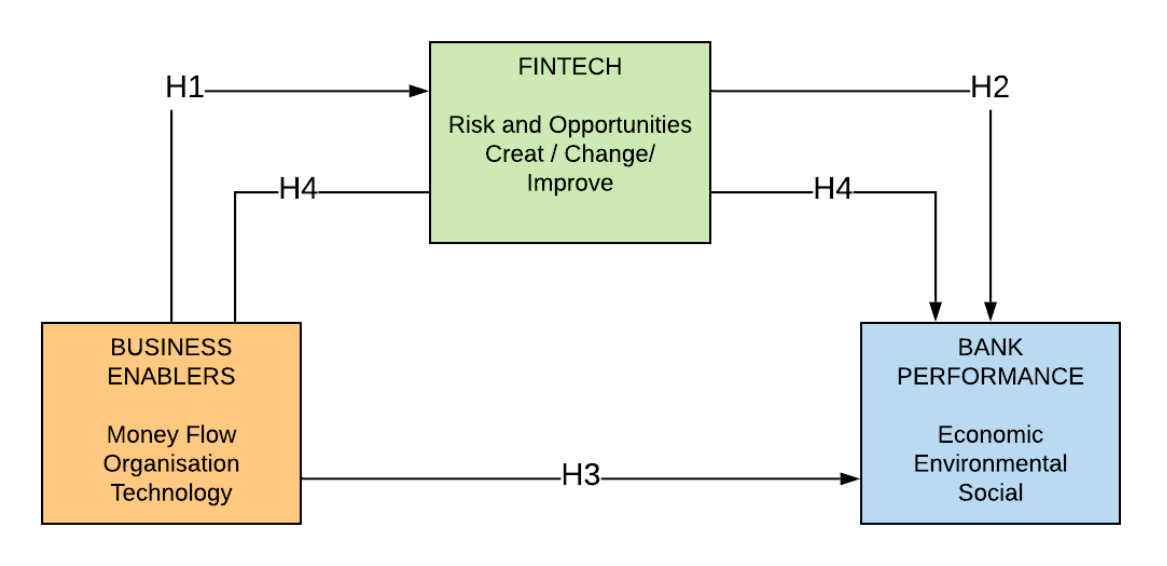
Figure 1. Conceptual